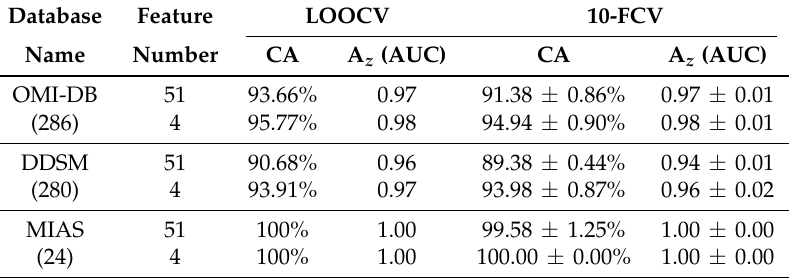
Table 6. Classification accuracy using LOOCV and 10-fold CV applying all 51 and the 4 most salient features from digitized mammogram using stacked generalization. The images were segmented without following the clinical grounding of cluster distribution. Naive Bayes was used as the